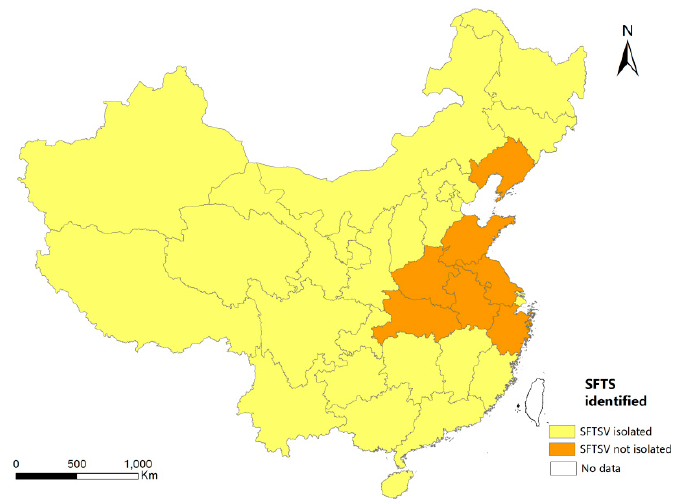
Figure 1. Geographical distribution of SFTSV in mainland China from 2010 to 2012. SFTSV = severe fever with thrombocytopenia syndrome virus. fever with thrombocytopenia syndrome